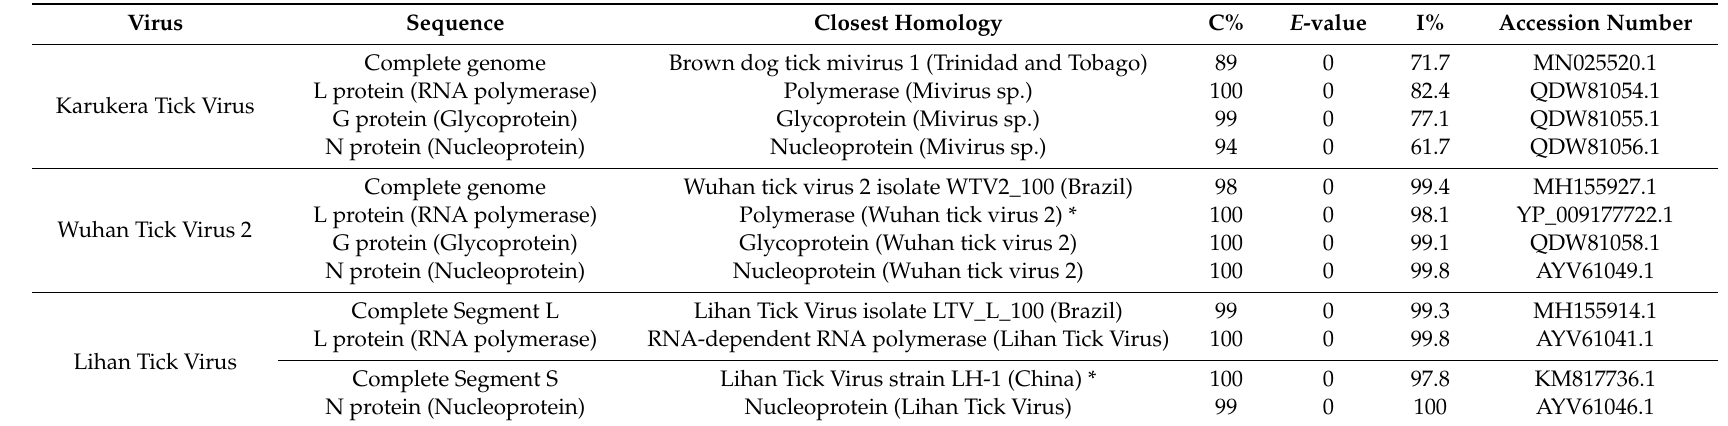
Table 3. Closest homology for genome viruses and ORF using sequence identity search from the NCBI nucleotide databases with the Basic Local Alignment Search Tool (blastn algorithmes for genome sequences and blastp algorithmes for protein sequences) (October 2019). C%: query coverage (%); I% query identity (%). *: Prototype